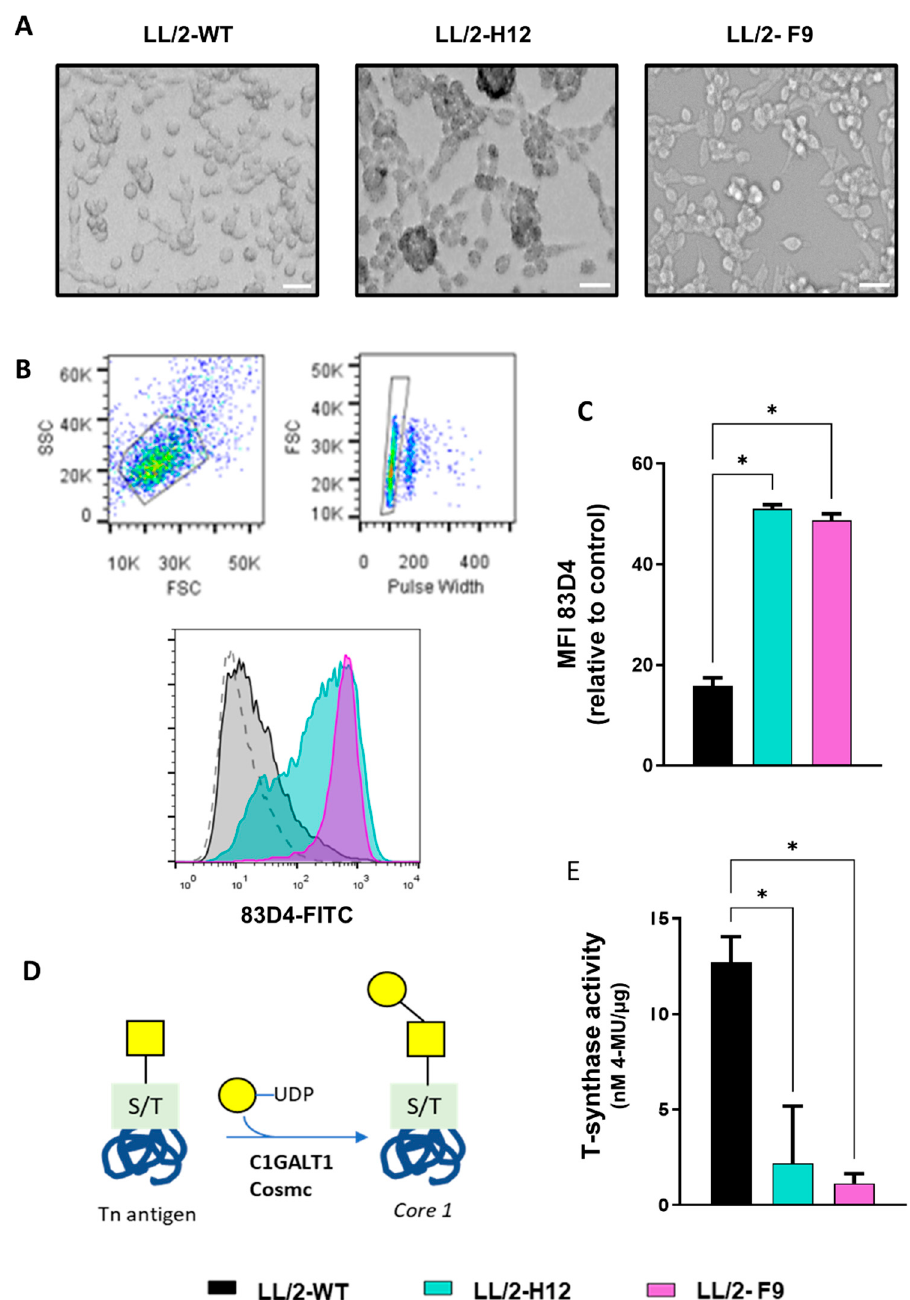
Figure 1. Generation of Tn + LL/2 cells. ( A ) Morphology of LL/2 WT and Tn + cells (LL/2- Tn + -H12 and LL/2-Tn + -F9). The white bar represents 20 µ m. ( B ) Expression of Tn antigen by flow cytometry in LL/2 tumor cells. Representing gating strategy and histogram of 83D4 staining on LL/2-WT (black), LL/2-Tn + -H12 (green), and LL/2-Tn + -F9 (purple) cells. The dotted line represents the non-stained negative control. ( C ) Median fluorescence intensity (MFI) of 83D4 staining normalized to negative control incubating cells only with secondary antibody FITC-conjugated (dotted histogram). ( D ) Representation of the Tn elongation to core 1 by the core 1 synthase (C1GALT1, T-synthase) enzyme together with the Cosmc chaperone. ( E ) T-synthase activity was measured as nM of 4-Methylumbel- liferone (4-MU) per µg of total protein. Asterisks represent significant differences ( p < 0.05).